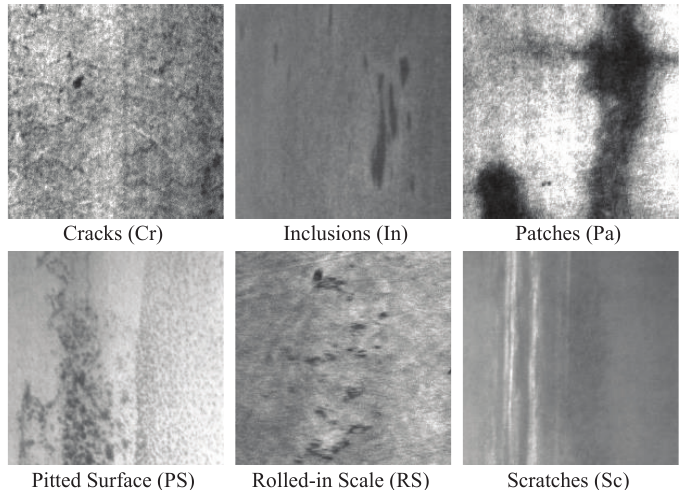
Figure 5. Sample images in the NEU-CLS